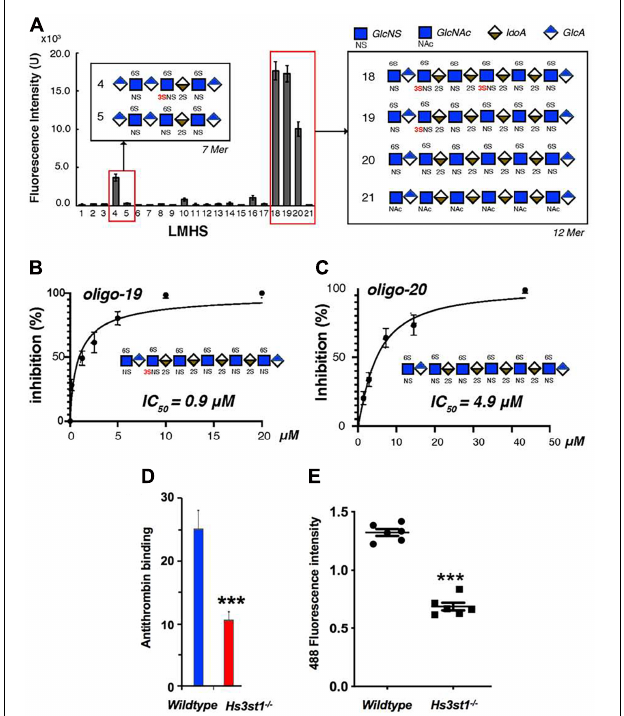
FIGURE 5 | Evidence for the Role of 3- O Sulfation in HS Tau Binding. (A) A low molecular weight heparan sulfate (LMHS) binding array shows 3-O sulfated glycans exhibit enhanced tau binding compared to otherwise identical structures. Oligosaccharides (B) 19 and (C) 20 from the LHMS differ only by a single 3-O sulfo group, yet exhibit a more than 5 fold difference their in inhibition constants as measured by competition SPR. (D) Knockdown of Hs3st1 in mice lung endothelial cells significantly reduces the binding of antithrombin—a canonical 3-O-S binding protein—to HS (E) and the uptake of fluorescently labeled tau compared to wild type cells. Adapted from Zhao et al.